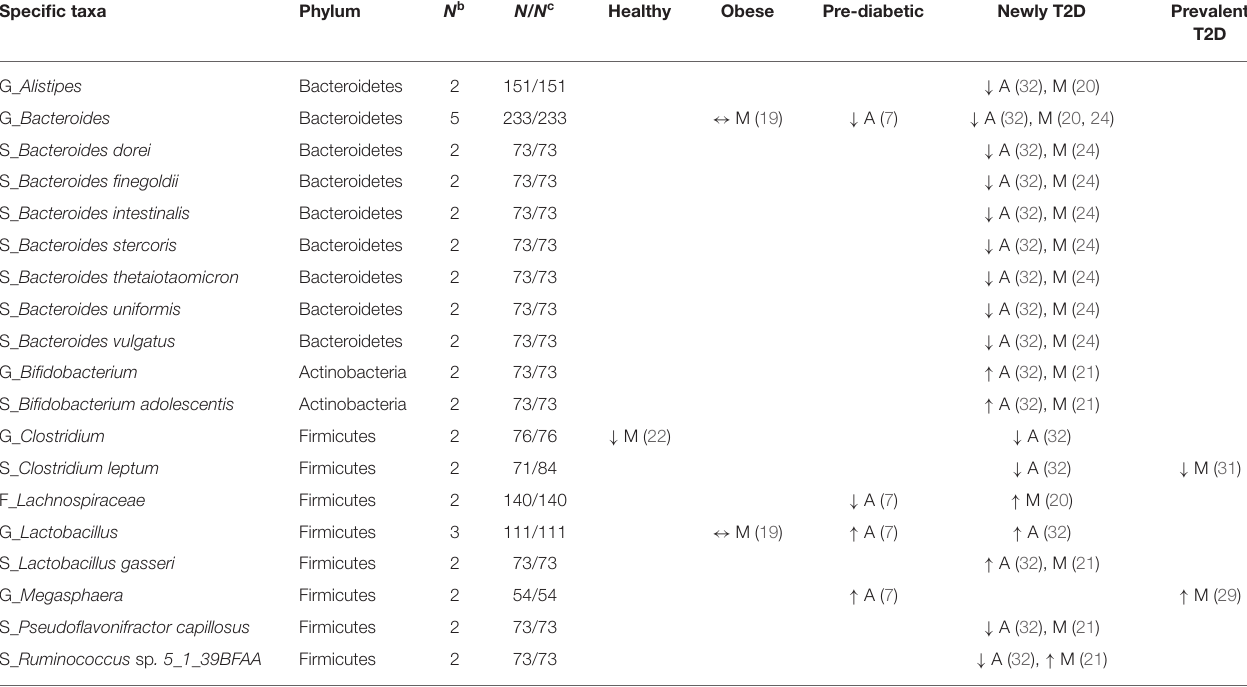
TABLE 4 | Effects of anti-hyperglycemic drugs on specific taxa in human gut microbiota, categorized by the target research populations a . Specific